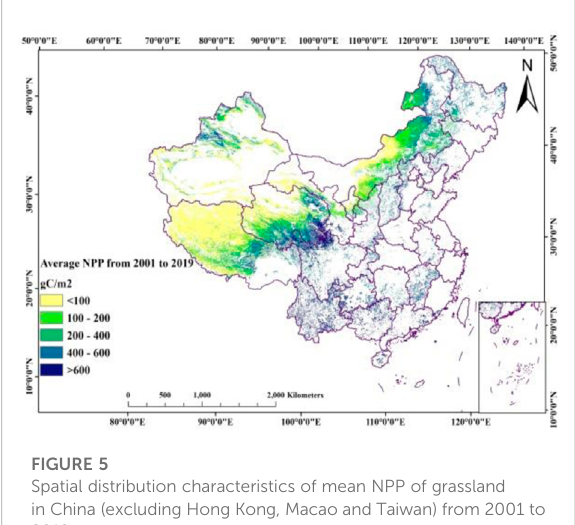
FIGURE 5 Spatial distribution characteristics of mean NPP of grassland in China (excluding Hong Kong, Macao and Taiwan) from 2001 to